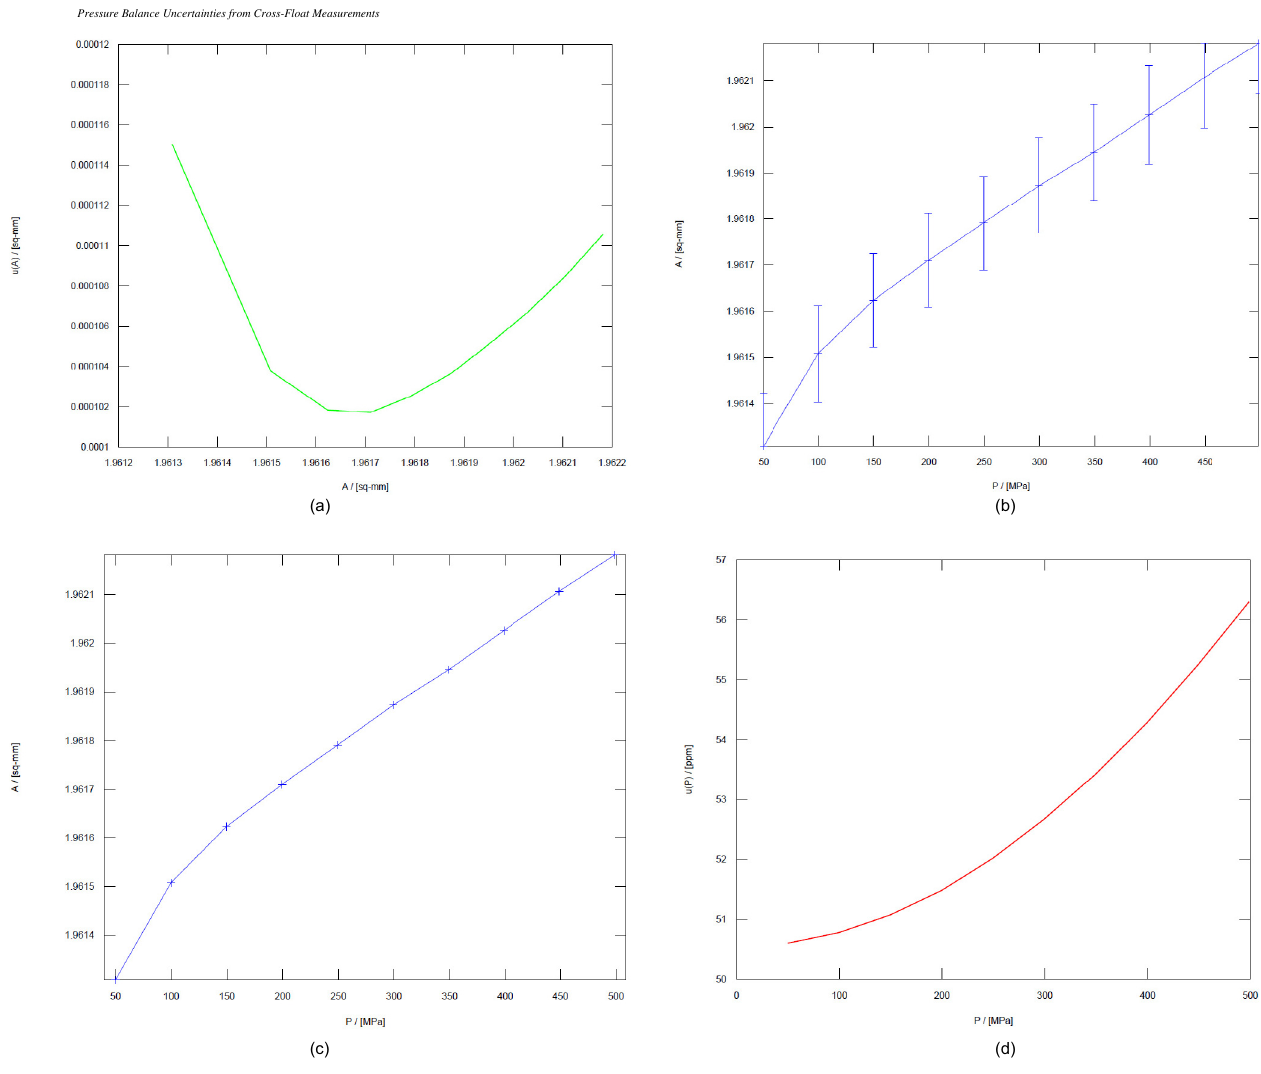
Fig. 2. (Color online) Characteristics and associated uncertainty contributors in direct pressure/area method calculations for a transfer standard pressure balance cross-floated againsts a laboratory standard pressure balance. (a) Uncertainty of transfer standard cross-floated area. (b) Variation of transfer standard uncertainty in cross-floated area with pressure. (c) Actual experimental applied pressure vs. transfer standard cross-floated area. (d) Uncertainty in laboratory standard generated applied